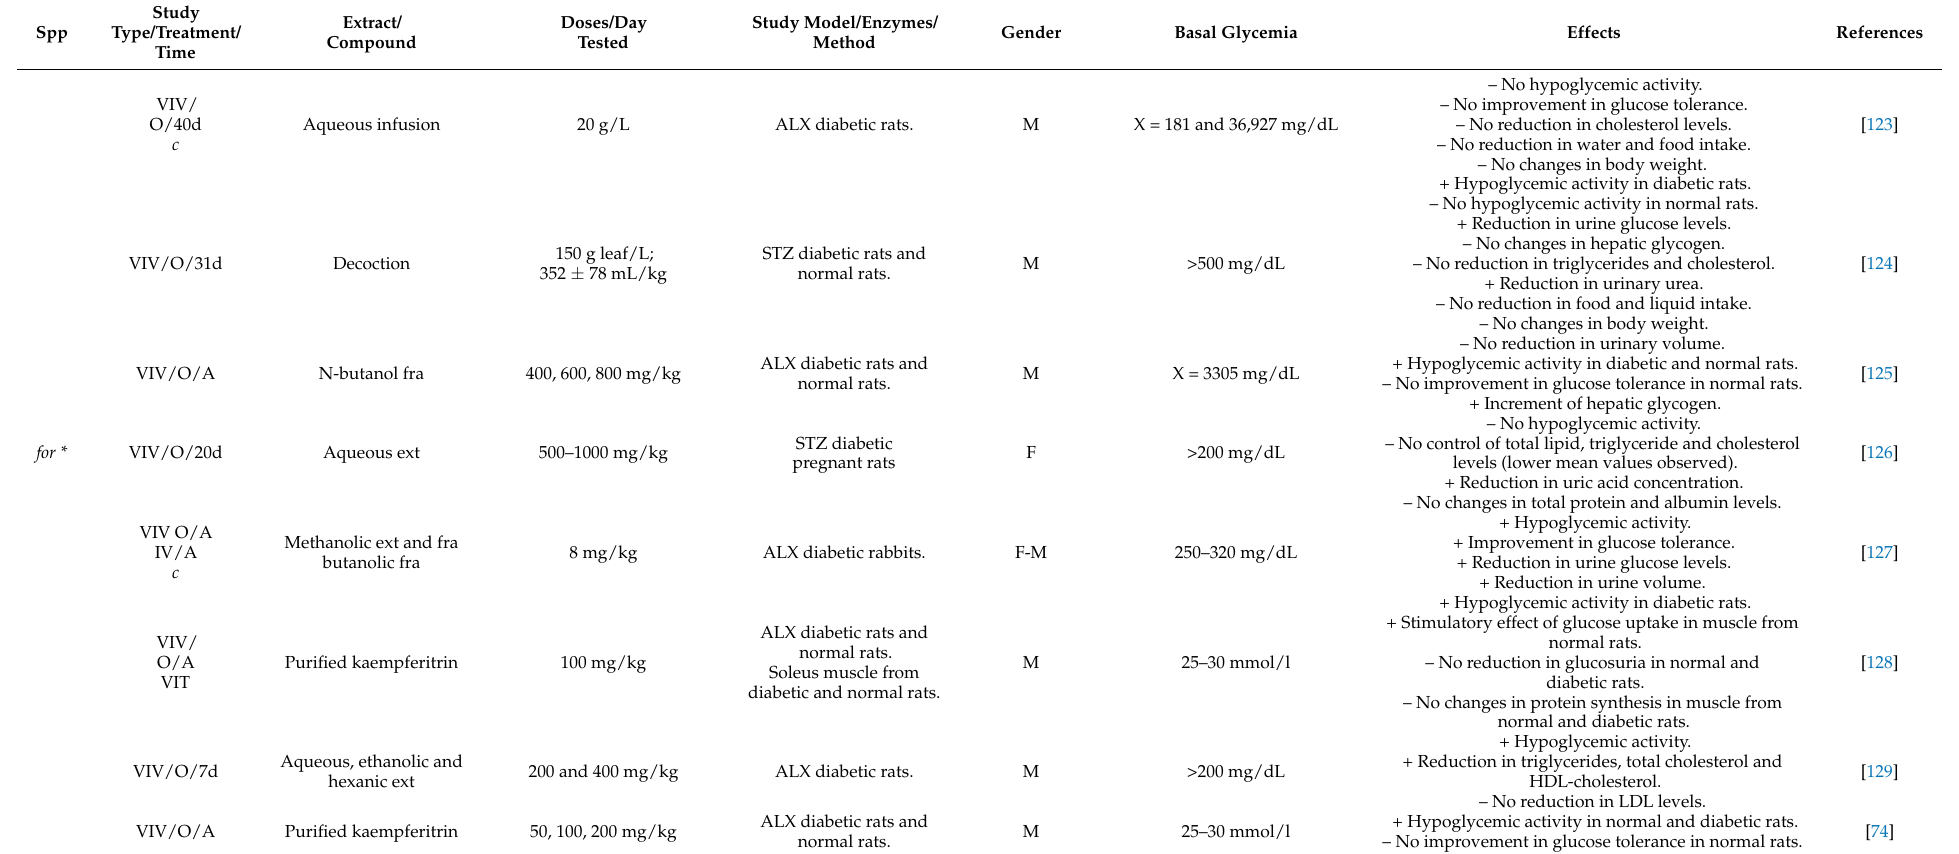
Table 3. Main antidiabetic properties and related activities of Bauhinia forficata and B. holophylla . Model animals were Wistar rats, Swiss mice or New Zealand rabbits, except where